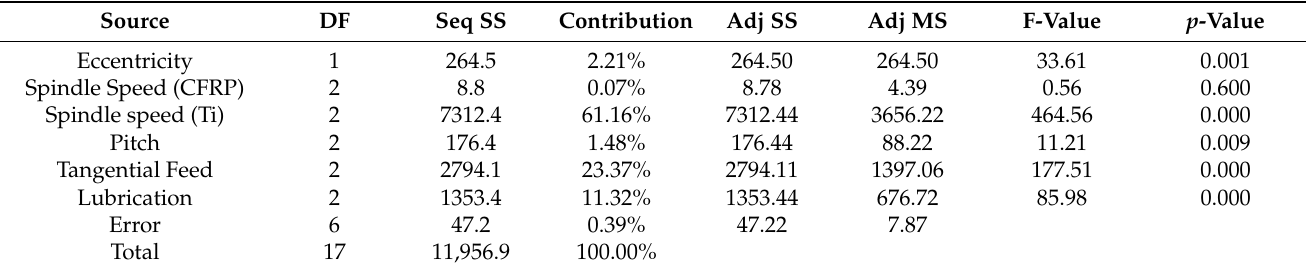
Table 10. Analysis of variance of flank wear.